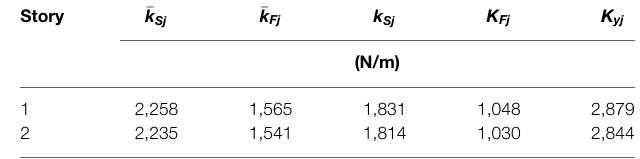
TABLE 3 | Lateral stiffness identified from static loading test.